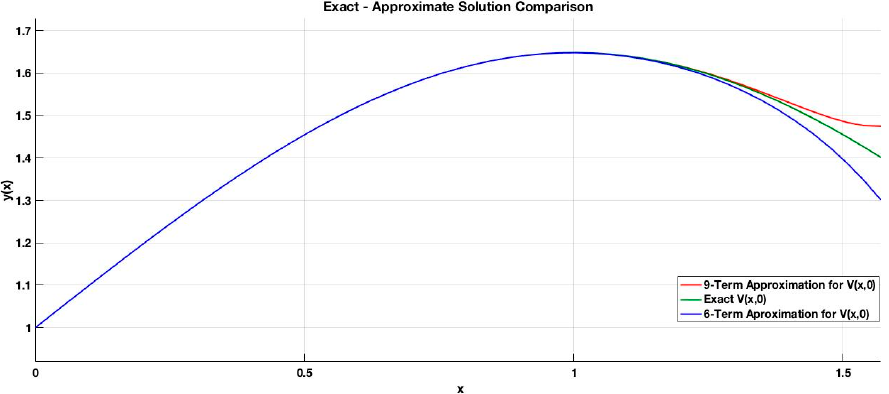
Figure 3. Exact-approximate solution comparison. Exact homogenous solution to Equation (103) compared to solutions with six-term and nine-term expansions for 𝑉(𝑥, 0) . Initial values are 𝑦 (cid:2868) = 1 and 𝑦 (cid:2868) (cid:4662) = 1 .